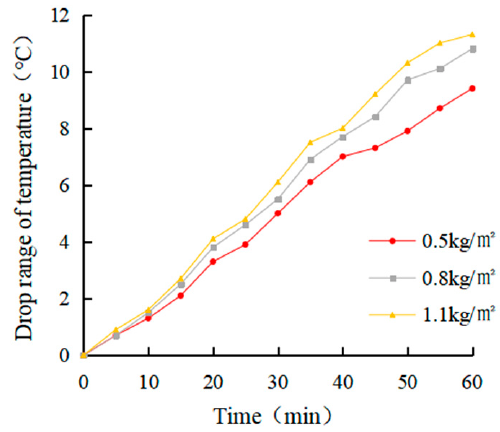
Figure 12. Internal cooling value diagram.